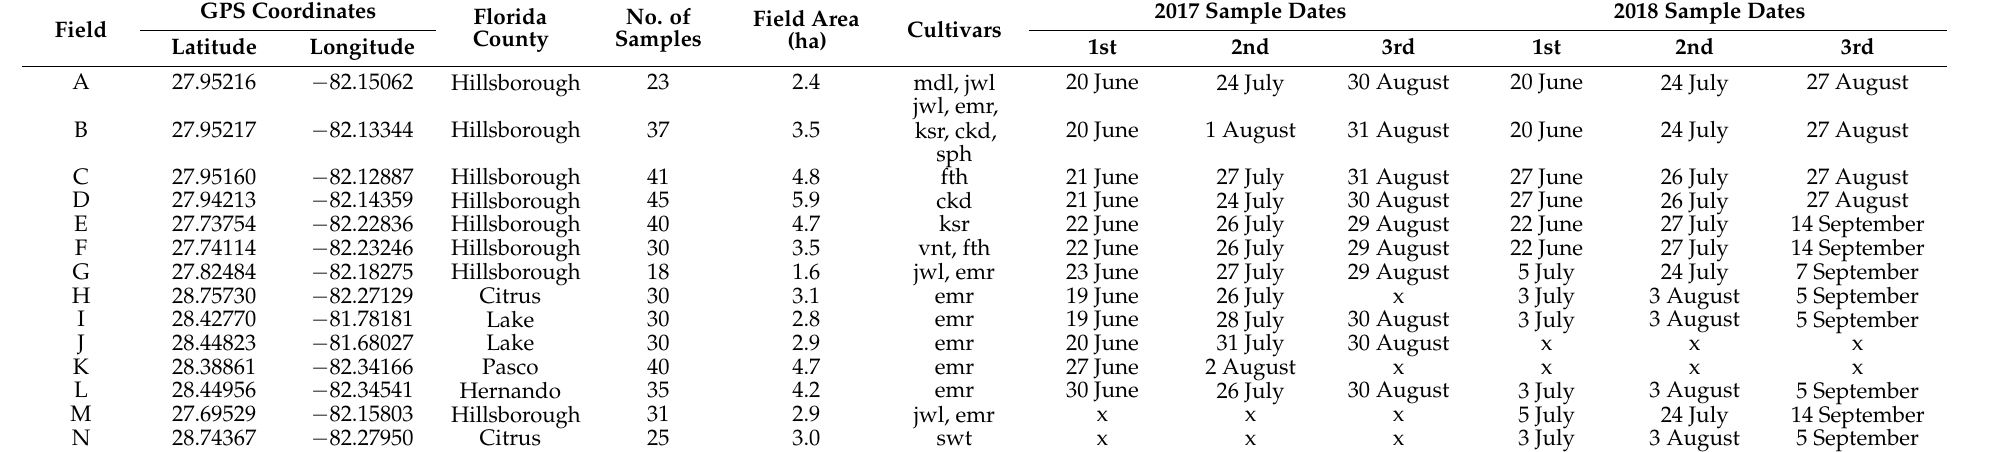
Table 1. Location, characteristics, and sampling dates of blueberry fields (14) in central Florida where young blueberry shoots were sampled randomly for S. dorsalis during summers of 2017 and 2018.